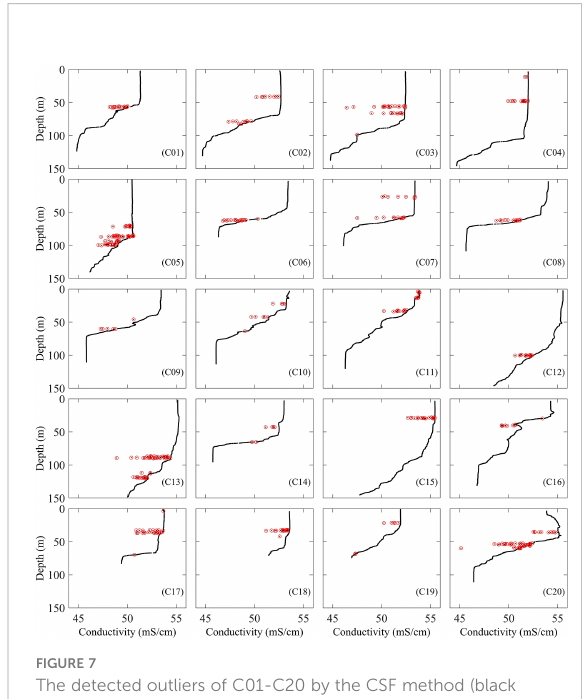
FIGURE 7 The detected outliers of C01-C20 by the CSF method (black points are the original data, red points are the detected outliers).